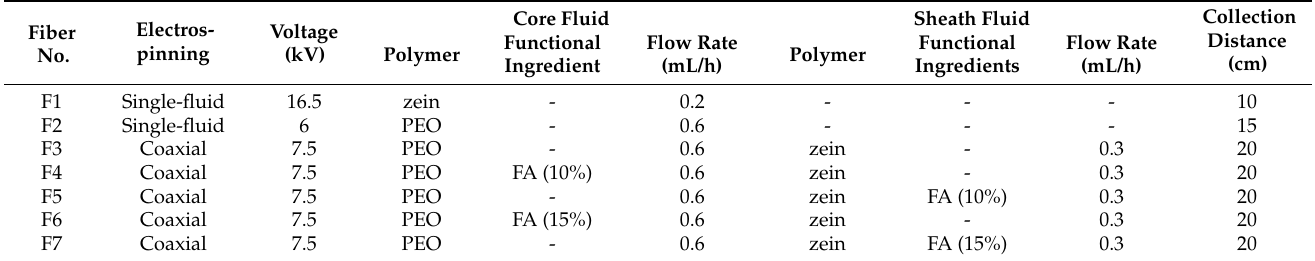
Table 1. Electrospinning processing parameters for the prepared